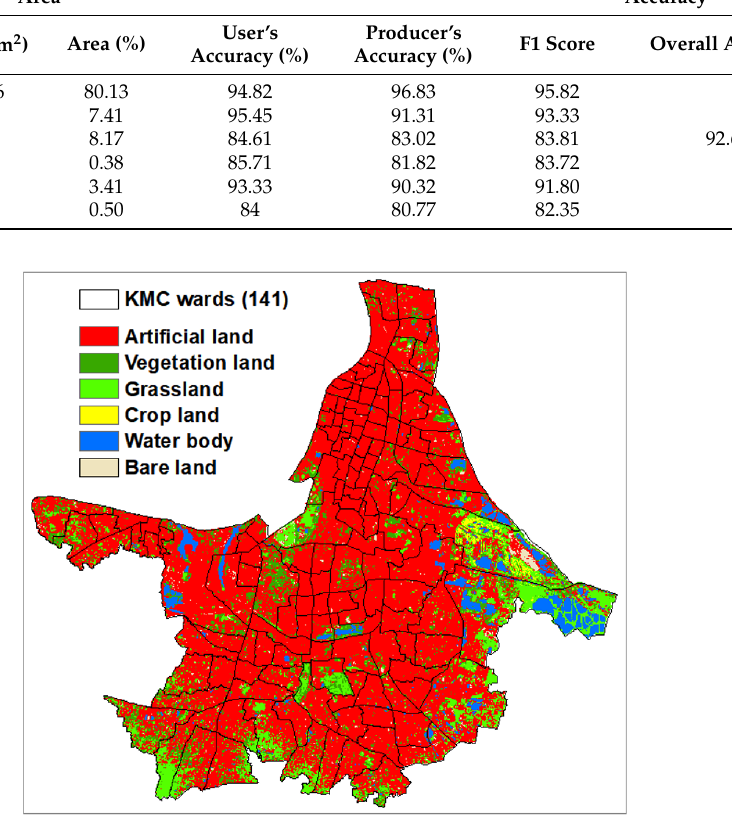
Figure 3. Land use land cover types of the study